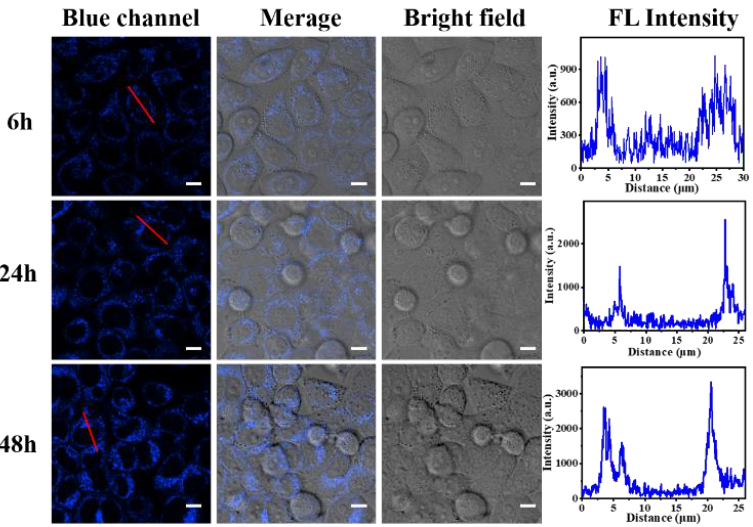
Figure 11. Time-dependent CLSM images of HeLa cells incubated with P(NA-AA) − 0 − 0.1 at a concentration of 20 µ g/mL. The scale bars are 10 µ m.